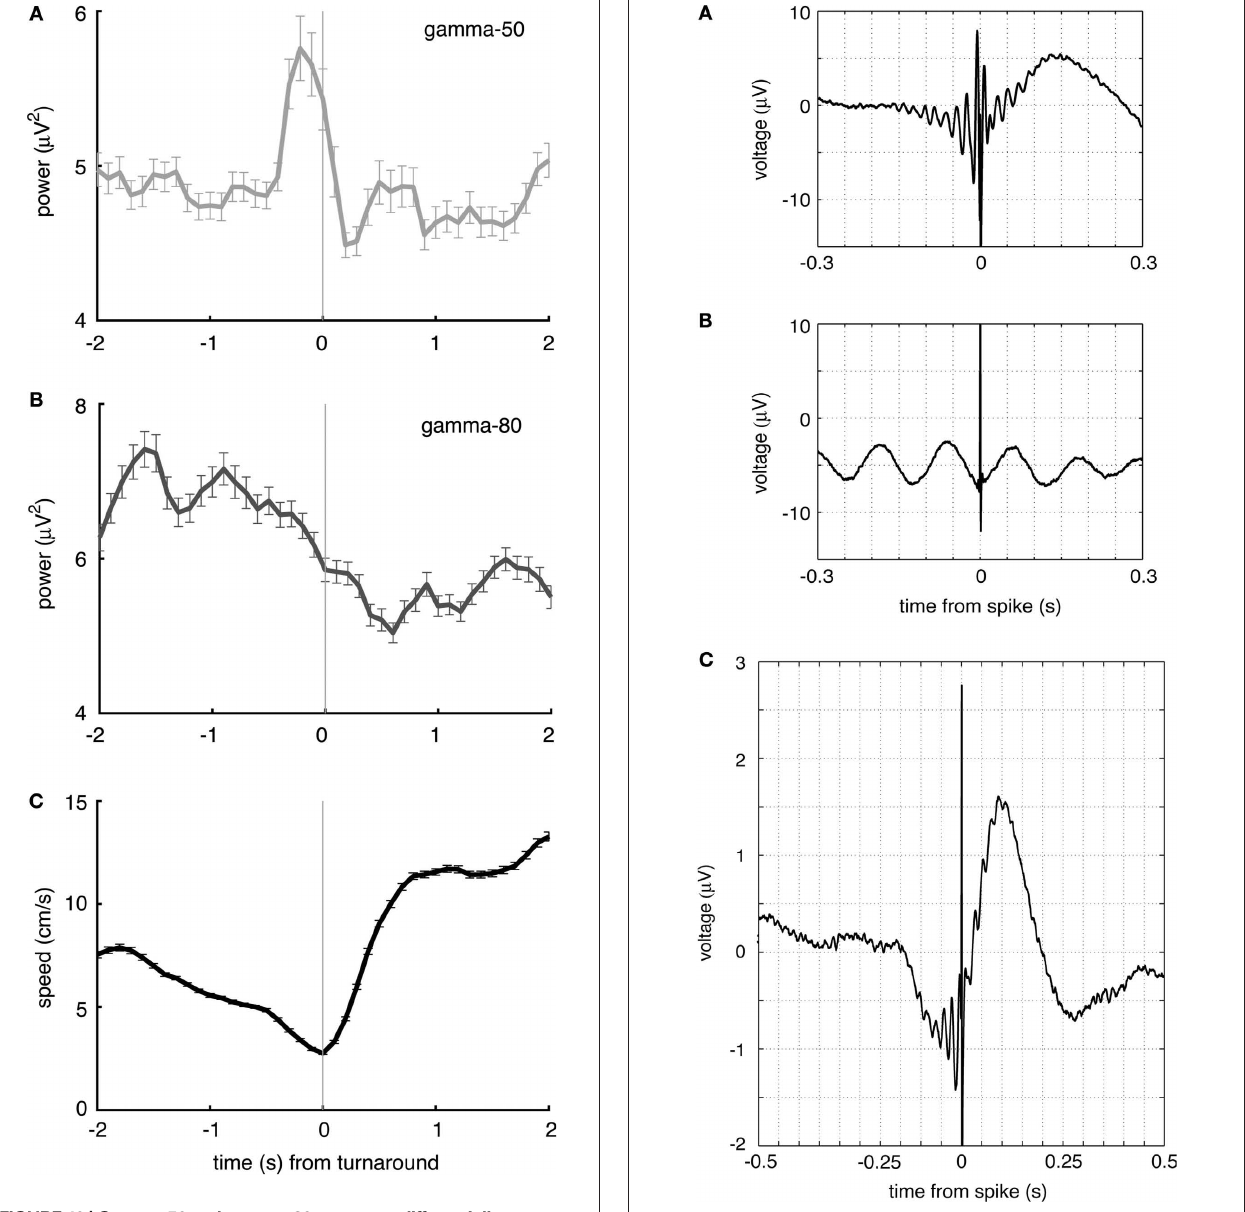
no such patterns.) For both gamma-50 and gamma-80, the majority of FSIs showed a small but signifi cant phase preference (Rayleigh’s r , p < 0.001, corrected for multiple comparisons; 32/53 for